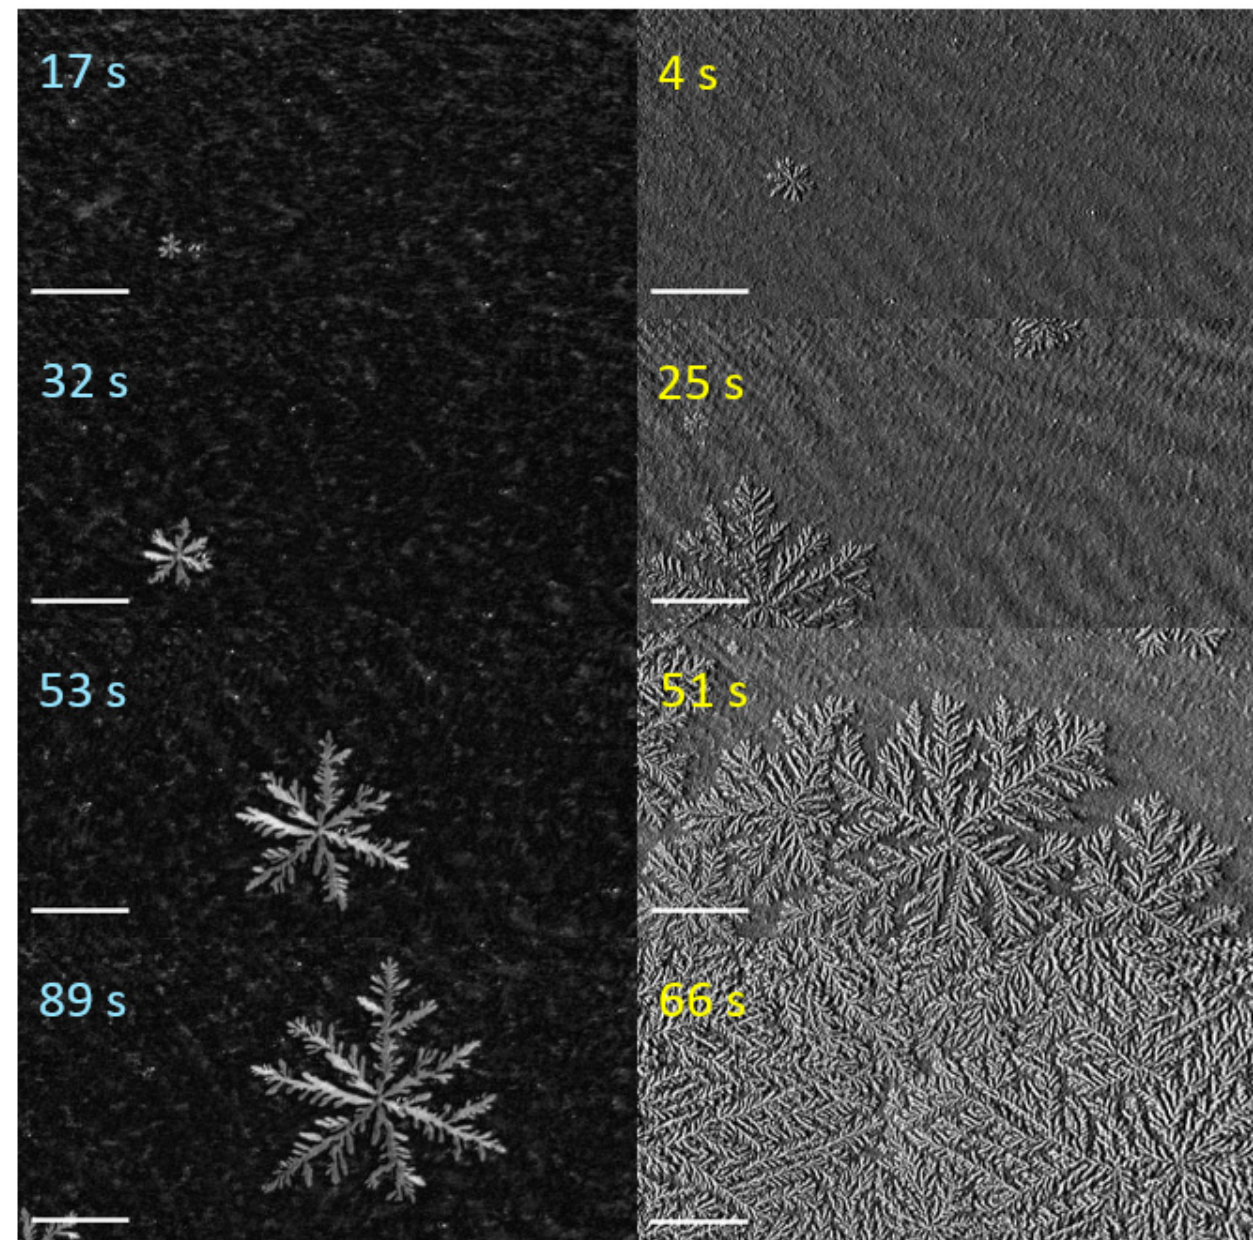
Figure 2. Domain growth in the LE/LC coexistence region of slowly (left, v C = 1.2 ˚A 2 / ( molecule · min ) ) and quickly compressed erucic acid monolayers (right, v C = 2.3 ˚A 2 / ( molecule · min ) ). The images were obtained with Brewster angle microscopy; all scale bars are 100 µ m long. Experimental conditions as in Figure 1.